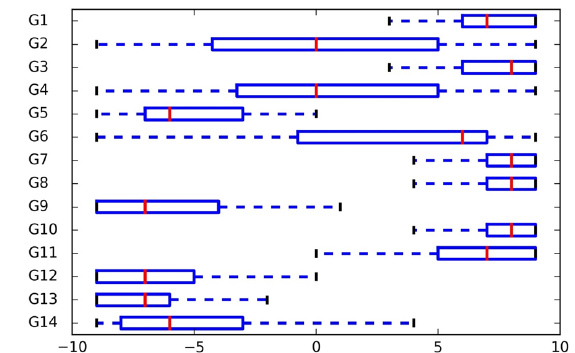
Views on geothermal energy by Kenyan (semi-)experts. In the boxplots the median is represented by a red line, the first and third quartiles form the edges of the box and the whiskers extend from the hinges of the box to the 5 th and 95 th